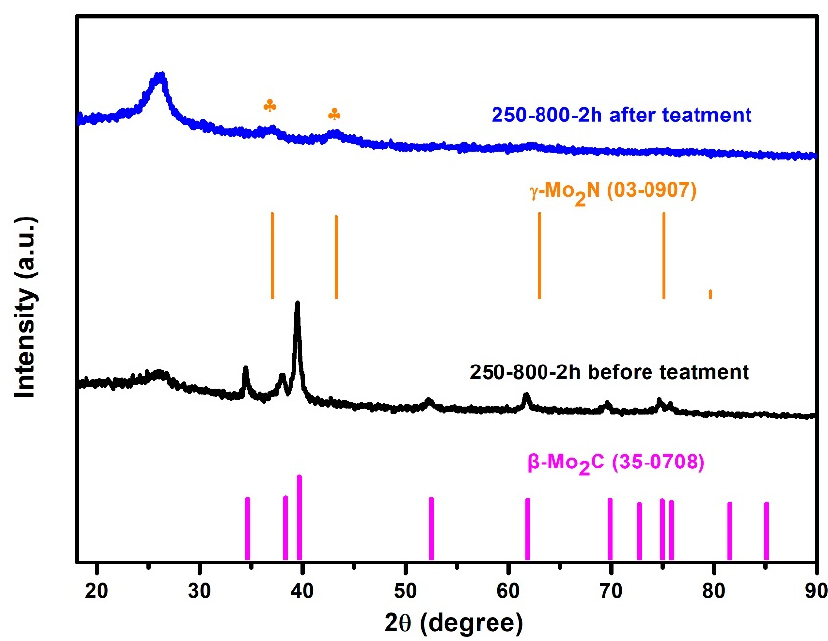
Figure 6. XRD patterns of the 250-800-2h catalyst before and after acid treatment.